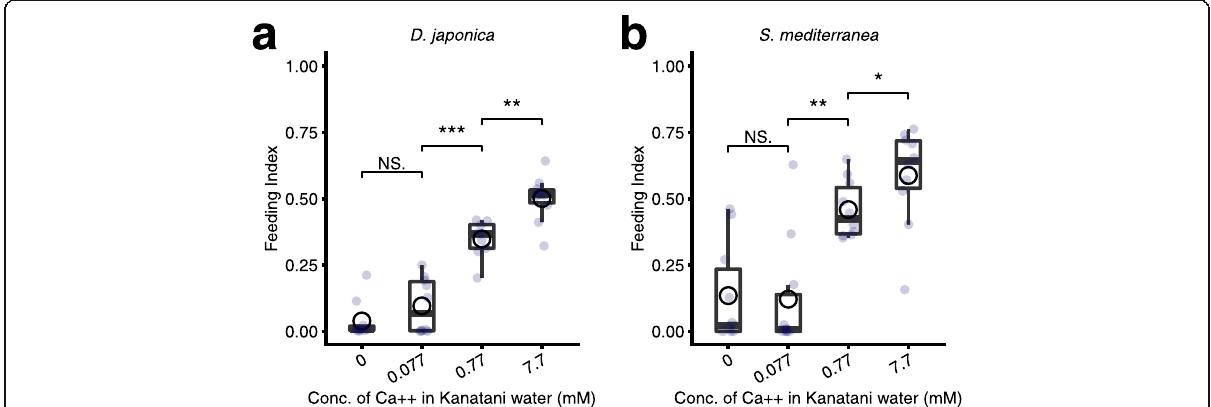
Fig. 6 Calcium ions are required for and improve food intake. a . Feeding indexes of D. japonica in Kanatani water lacking calcium ions (Ca ++ ( − )), Kanatani water containing a low concentration of calcium ions (0.1x Ca ++ ), original Kanatani water (1x Ca ++ ) or Kanatani water containing excess calcium ions (10x Ca ++ ). b . Feeding indexes of S. mediterranea under the same conditions as tested in D. japonica . n = 10; NS, not significant; *, p < 0.05; **, p < 0.01; ***, p < 0.005 (Wilcoxon